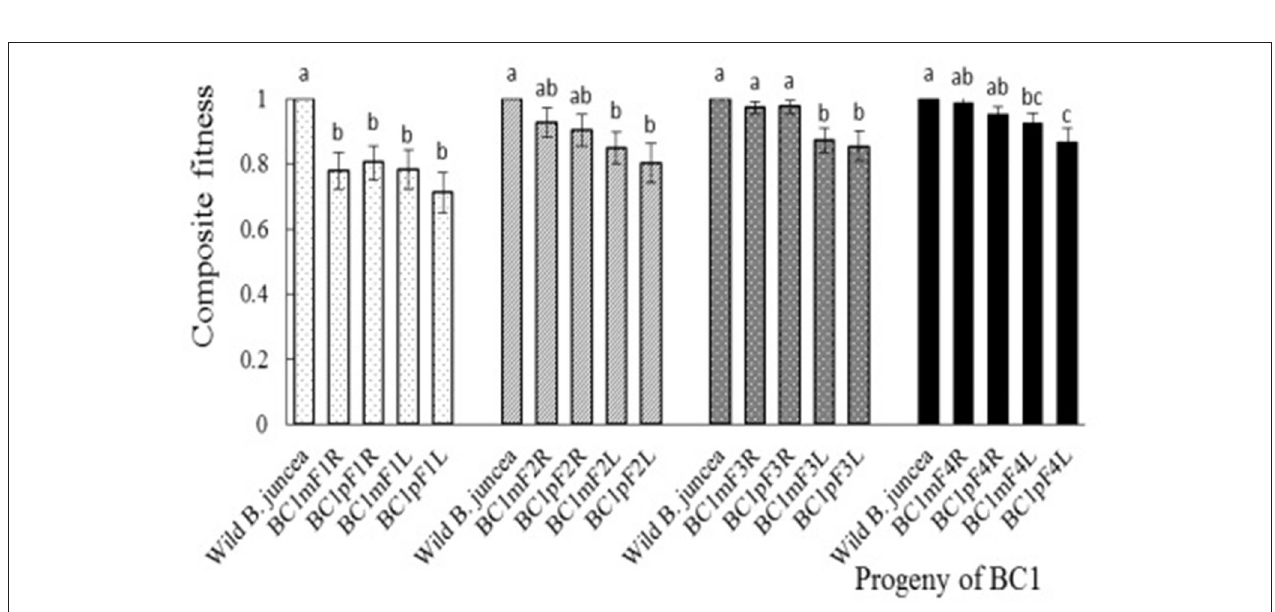
FIGURE 4 | Composite fitness of the first- to fourth-generation progenies of BC1. To estimate relative fitness, the agronomic traits of Brassica juncea were defined as “1.” Data were shown as the mean ± SE ( n = 8). Different letters in the different progenies of the same generation indicate significant differences using Duncan’s multiple range test, P < 0.05. BC1mF1R to BC1mF4R and BC1pF1R to BC1pF4R are the glyphosate-tolerant first- to fourth-generation progenies of the first backcross generation (BC1), obtained from wild Brassica juncea × F1R or F1R × wild B. juncea , respectively. BC1mF1L to BC1mF4L and BC1pF1L to BC1pF4L are the glufosinate-tolerant first- to fourth-generation progenies of the first backcross generation (BC1) obtained from wild Brassica juncea × F1L or F1L × wild B. juncea , respectively. F1R and F1L indicate glyphosate- or glufosinate-tolerant F1 hybrids obtained from wild B. juncea × glyphosate- or glufosinate-tolerant transgenic oilseed rape. Progenitors in front of the × are always the maternal plants, and the progenitors after the × are always the paternal plants.